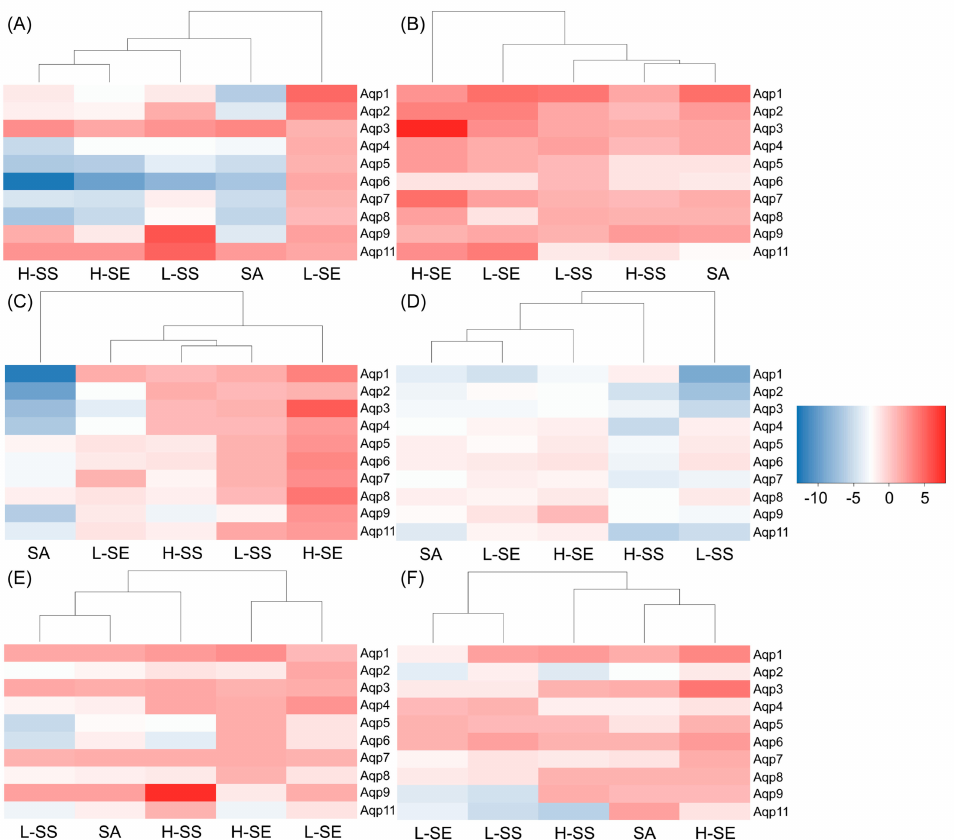
Figure 6. Heat map visualization with the Aqp alteration profiles in each organ collected from the diarrhea-rats induced by low dose of senna extract (L-SE), high dose of senna extract (L-SE), low dose of sennoside (L-SS), high dose of sennoside (H-SS), and one dose of sennoside A (SA) for over six days. ( A ) Aqp alteration profiles in the colons. ( B ) Aqp alteration profiles in the kidneys. ( C ) Aqp alteration profiles in the livers. ( D ) Aqp alteration profiles in the spleens. ( E ) Aqp alteration profiles in the stomachs. ( F ) Aqp alteration profiles in the lungs. The negative number represents the fold changes of down-regulated Aqps and the positive number represents the fold changes of up-regulated Aqps